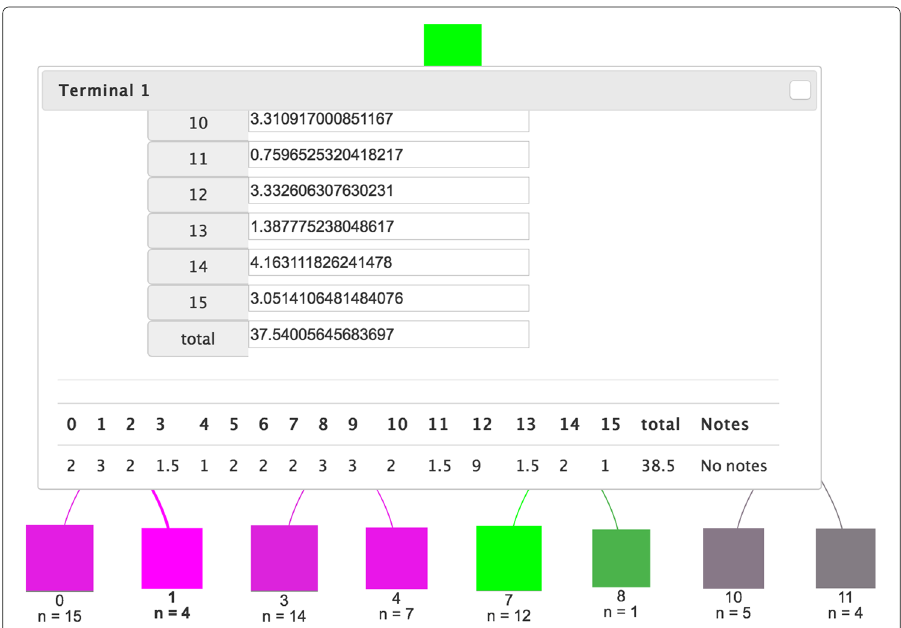
Fig. 6 An open node from Neural N-Tree in the interface